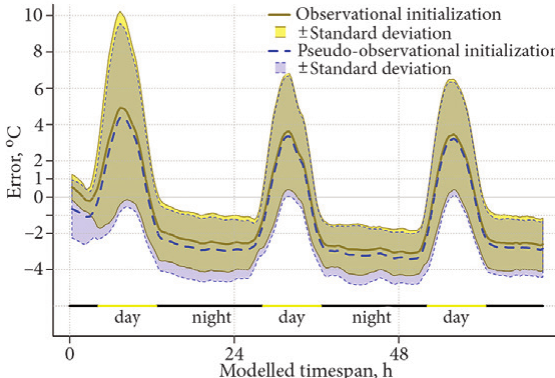
Fig. 7. Comparison of the forecast errors obtained for the obverational and pseudo-observational